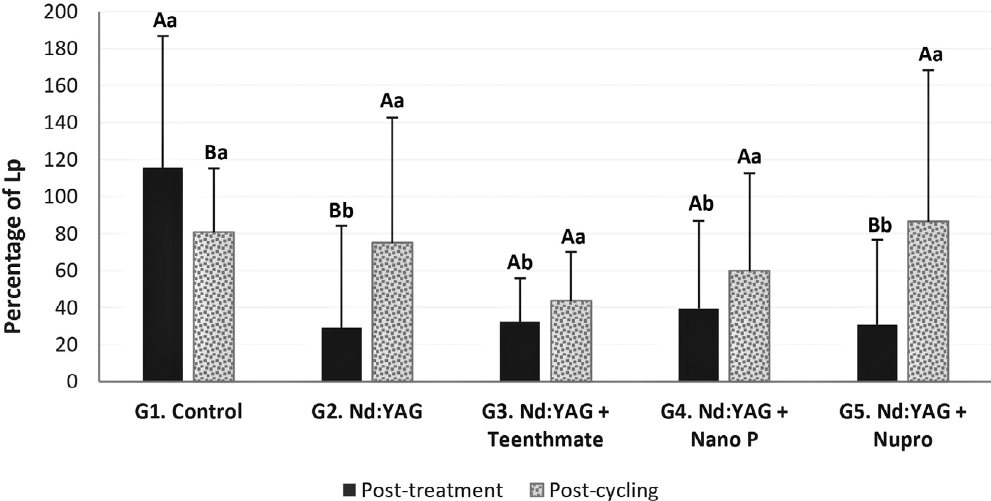
Figure 2- Means (standard deviations) of %Lp values for all groups at both experimental moments. Different Capital letters imply differences between experimental moments within groups (p≤0.05). Different lowercase letters denote differences among groups within moments